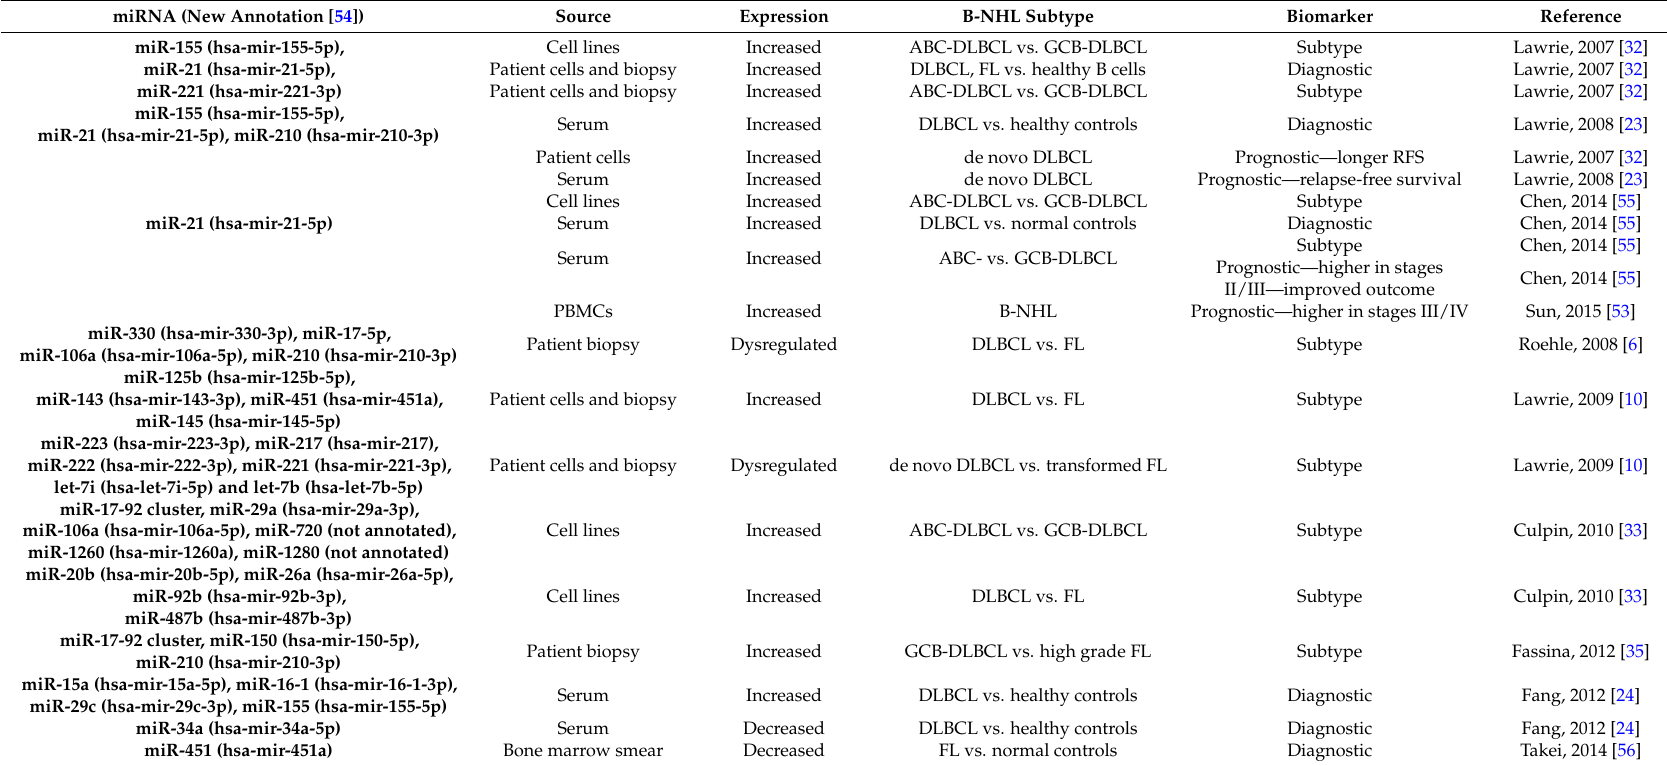
Table 1. A summary and comparison of dysregulated miRNAs that could be used as potential diagnostic, subtype and prognostic biomarkers in non-Hodgkin lymphoma